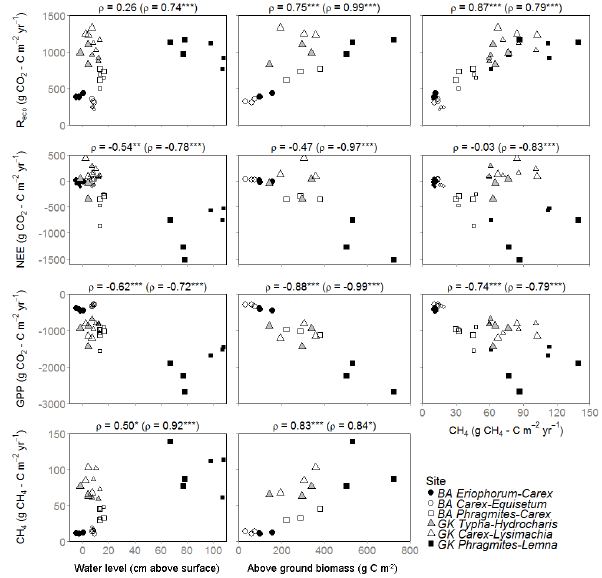
Figure 6. Scatter plots of annual NEE, R eco , GPP, CH 4 emissions, median annual water levels (both years for all plots, n = 36), and above-ground biomass carbon (second year for all plots, n = 18). Spearman’s ρ significant at ‘ P ≤ 0.05; ∗ P ≤ 0.01; ∗∗ P ≤ 0.001; ∗∗∗ P ≤ 0.0001. Spearman’s ρ in brackets without GK Typha– Hydrocharis and GK Carex–Lysimachia ( n = 30 for correlations among water levels and fluxes; n = 15 for correlations among biomass and fluxes). Small symbols indicate first year, large sym- bols second